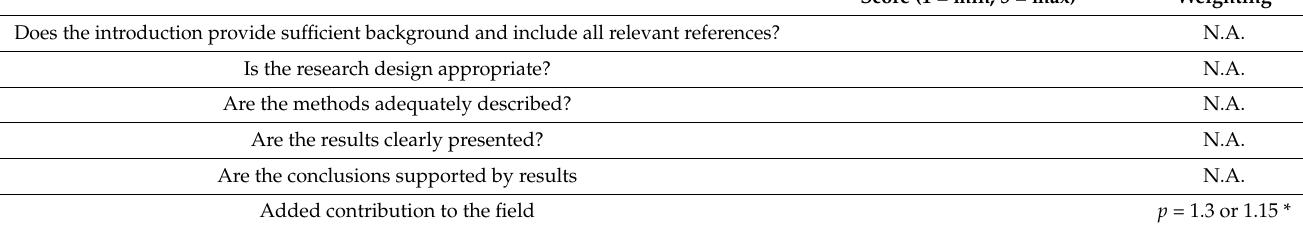
Table 1. Parameters used for the eligibility.